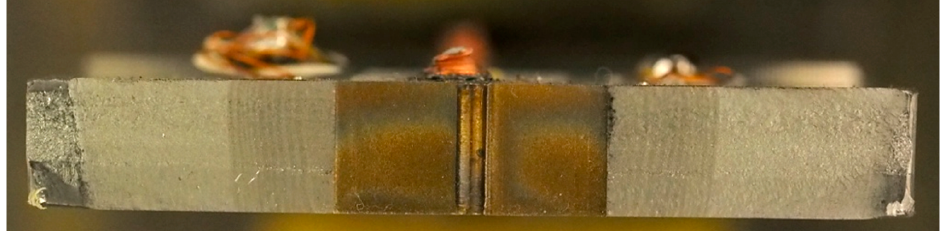
Figure 4. Fracture welded specimen with wire-eroded crack starter notch and visible beach marks.